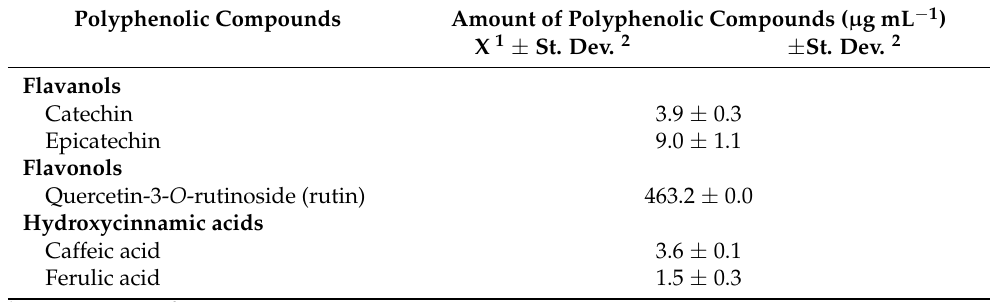
Table 1. The main phenolic compounds identified by HPLC-UV in the analyzed SN ethanolic extract. Polyphenolic